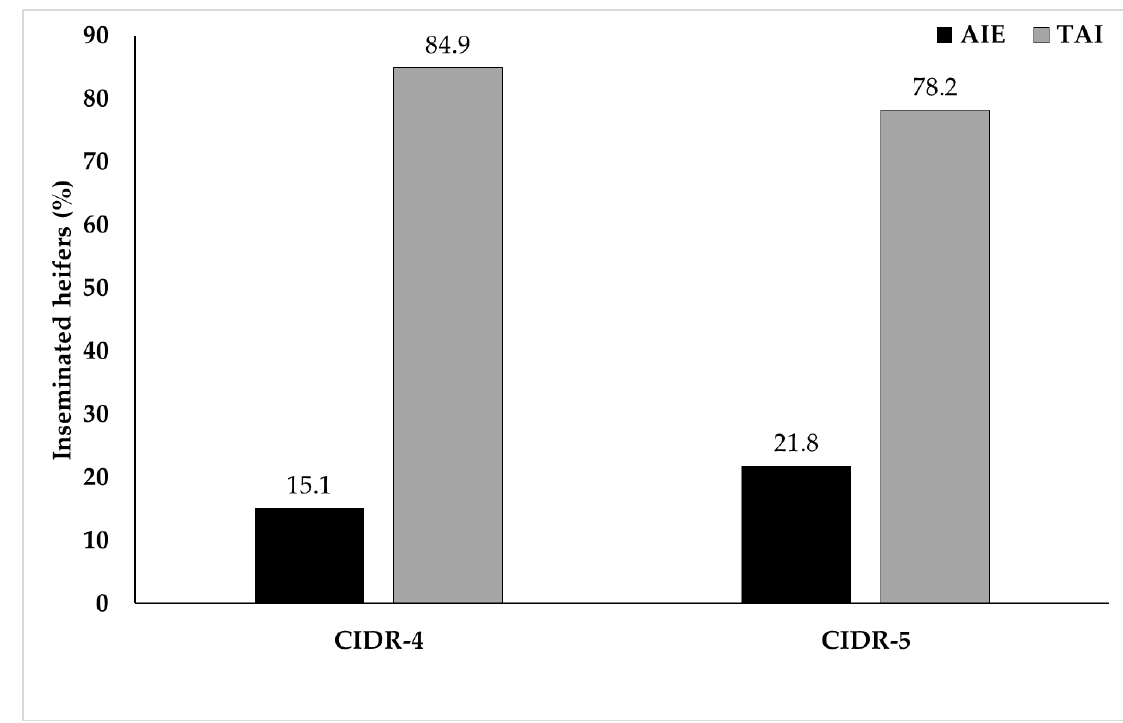
Figure 3. The distribution of AI at detected estruses (AIE, black bars) and timed artificial insemination (TAI, gray bars) in CIDR-4 and CIDR-5 groups. Rate of AIE was tended ( p < 0.09) to be higher in CIDR-5 group than that in CIDR-4